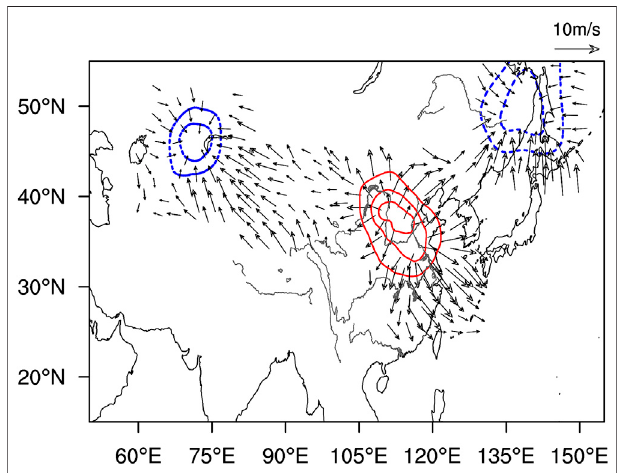
FIGURE 3 | The velocity potential (contours, unit: 106 m 2 s − 1 ) and divergent wind (arrow, unit: m s − 1 ) at 200 hPa during July 11 – 19, 2020. The red contour denotes the positive values, and the blue denotes the negative.